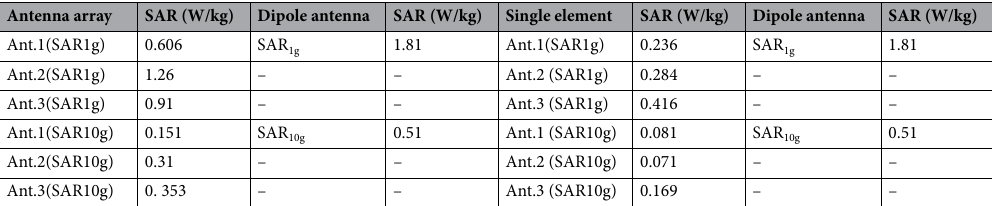
Table 3. The averaged SAR 1g and SAR 10g for 15 dBm input power.